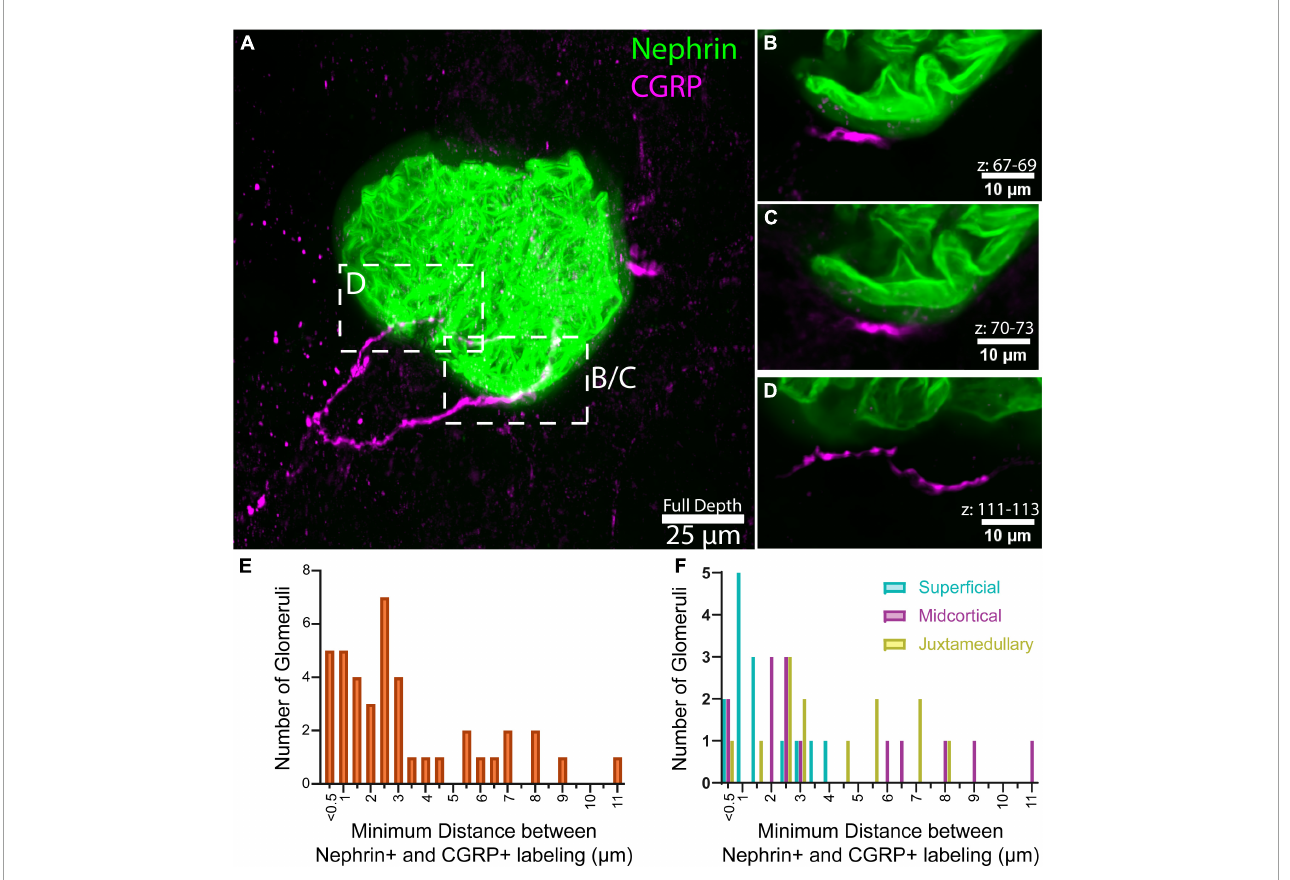
FIGURE3 Analysis of close appositions between glomeruli and afferent axons. (A) Maximum intensity projection of 136 optical sections, collected 0.65 µ m apart, total volume 88.4 µ m. (B–D) Maximum intensity projections of subvolumes of A depict close appositions between calcitonin gene related peptide (CGRP)+ axons and nephrin labeling. Optical section numbers included in each projection are indicated above the scale bars. CGRP labeling does not overlap with the halo-like fluorescence surrounding nephrin labeling (faint green), suggesting that the axons do not penetrate below Bowman’s capsule, but are immediately apposed to it. Panels (B,C) illustrate an approximately 11.2 µ m-long segment of CGRP labeling located 0.4–1.3 µ m from the halo-like fluorescence surrounding nephrin labeling. (E) Distribution of the minimum distance between nephrin and CGRP labeling in high-resolution images of 42 glomeruli ( n = 7 animals, 6 glomeruli per animal). (F) Minimum distance between nephrin and CGRP labeling by glomerular category, displayed as overlay [ n = 7 animals, 2 glomeruli per category each (42 total)]. Scale bars: (A) 25 µ m, (B–D) 10 µ